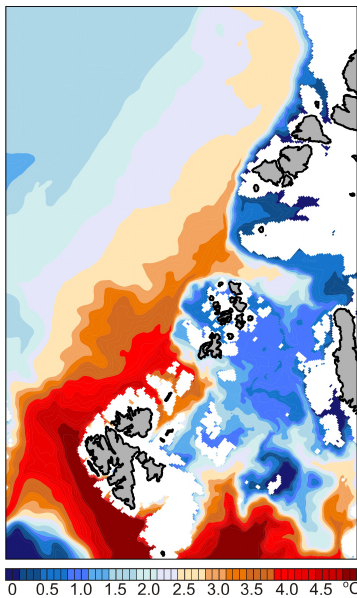
Figure 4. The maximum mean (2000–2009) simulated temperature ( ◦ C) in